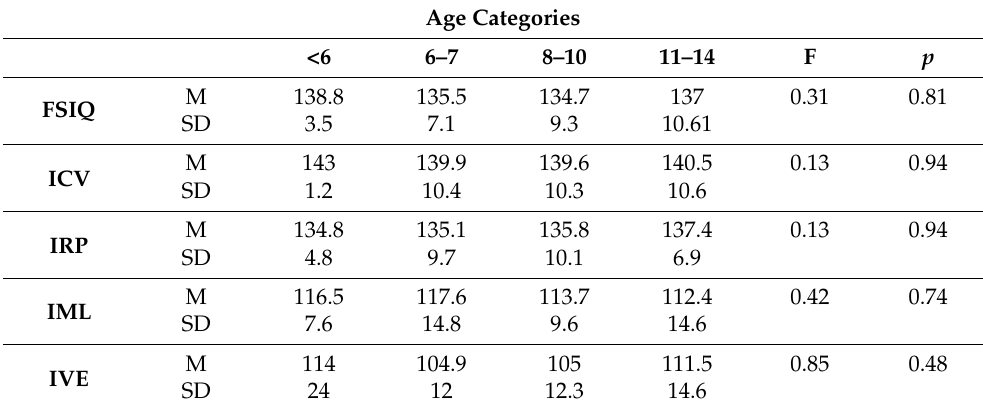
Table 2. WISC IV indexes average scores and standard deviations categorized by children’s